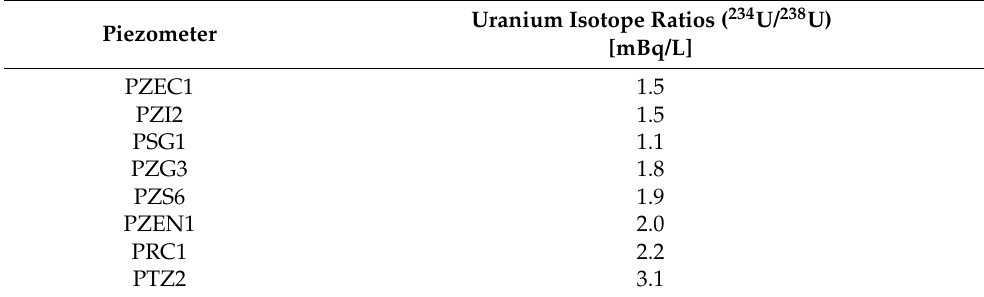
Table 5. Uranium Isotope Ratios Detected in the Monitored Piezometers (Median Values) [6].